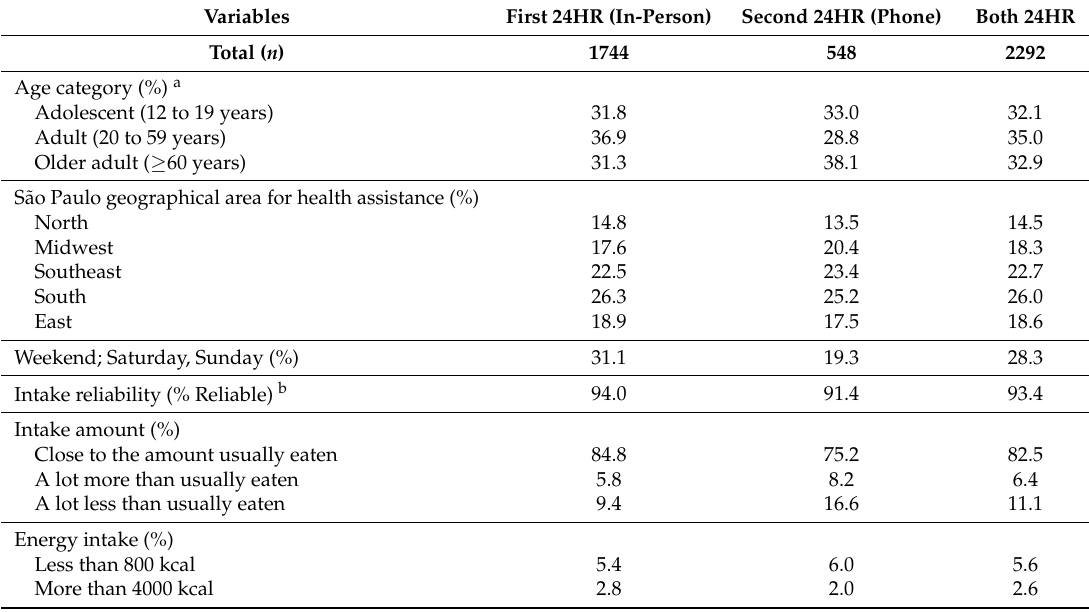
Table 2. Characteristics of the individuals who answered the 24-h dietary recall (24HR)